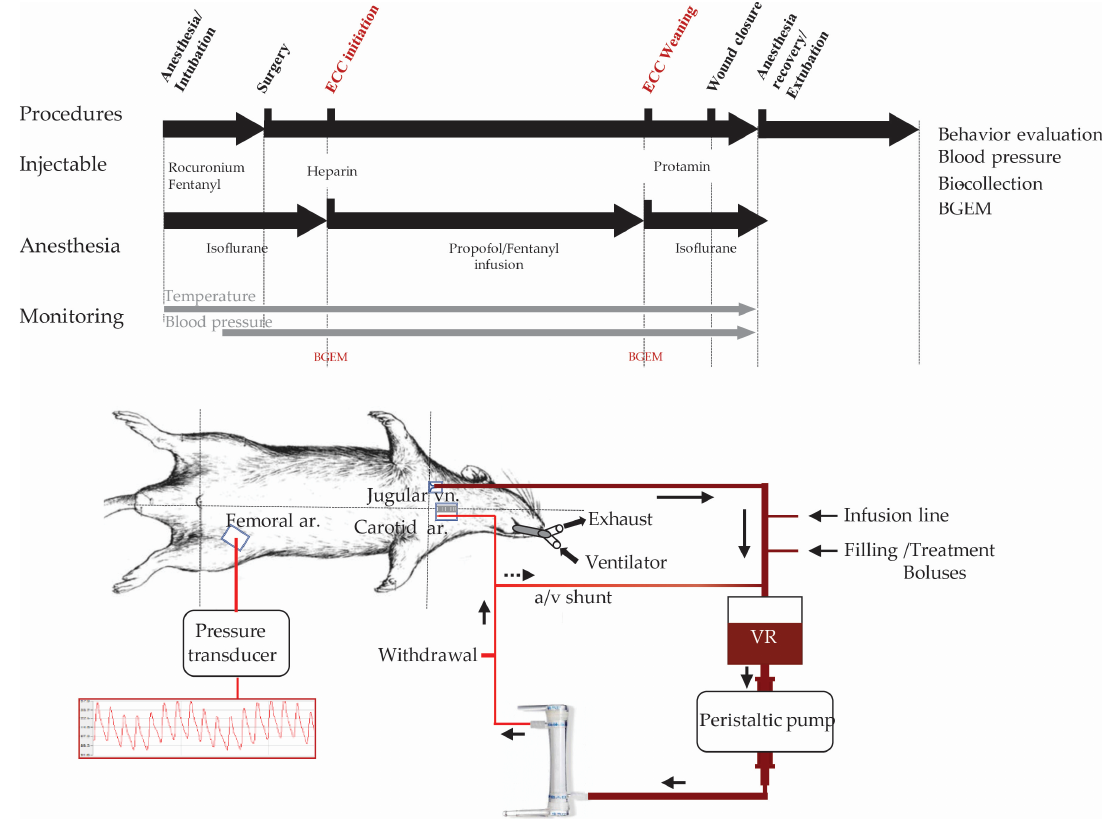
Figure 4. ECC montage, protocol, and hemodynamic monitoring a/v shunt: arterial/venous line shunt; VR: venous reservoir; ar.: femoral artery; vn.: vein. Protocol for ECC: Isoflurane was used for induction in a box at 5%, FiO 2 1.0, for maintenance with a mask at 2.5% and with an orotracheal probe (14 G), thanks to mechanical ventilation at 1.5%, FiO 2 1.0, 6 mL/kg tidal volume, 58 ± 2 cycle/min for maintenance of normocapnia. Fentanyl and rocuronium bromide boluses were administrated before intubation, respectively, at 12 µg/kg and 1 mg/kg, iv. During ECC, anesthesia was achieved with a propofol/ fentanyl infusion at, respectively, 30 mg/kg/h and 2 µg/kg/h. A total of 250 UI/kg unfraction- ated heparin was injected through the carotid catheter before initiation and was antagonized at the end of protocol, thanks to protamine sulfate. Extubating was achieved after the animal started breath- ing by itself. ECC: Extracorporeal circulation; BGEM: Blood gases electrolytes metabolites.